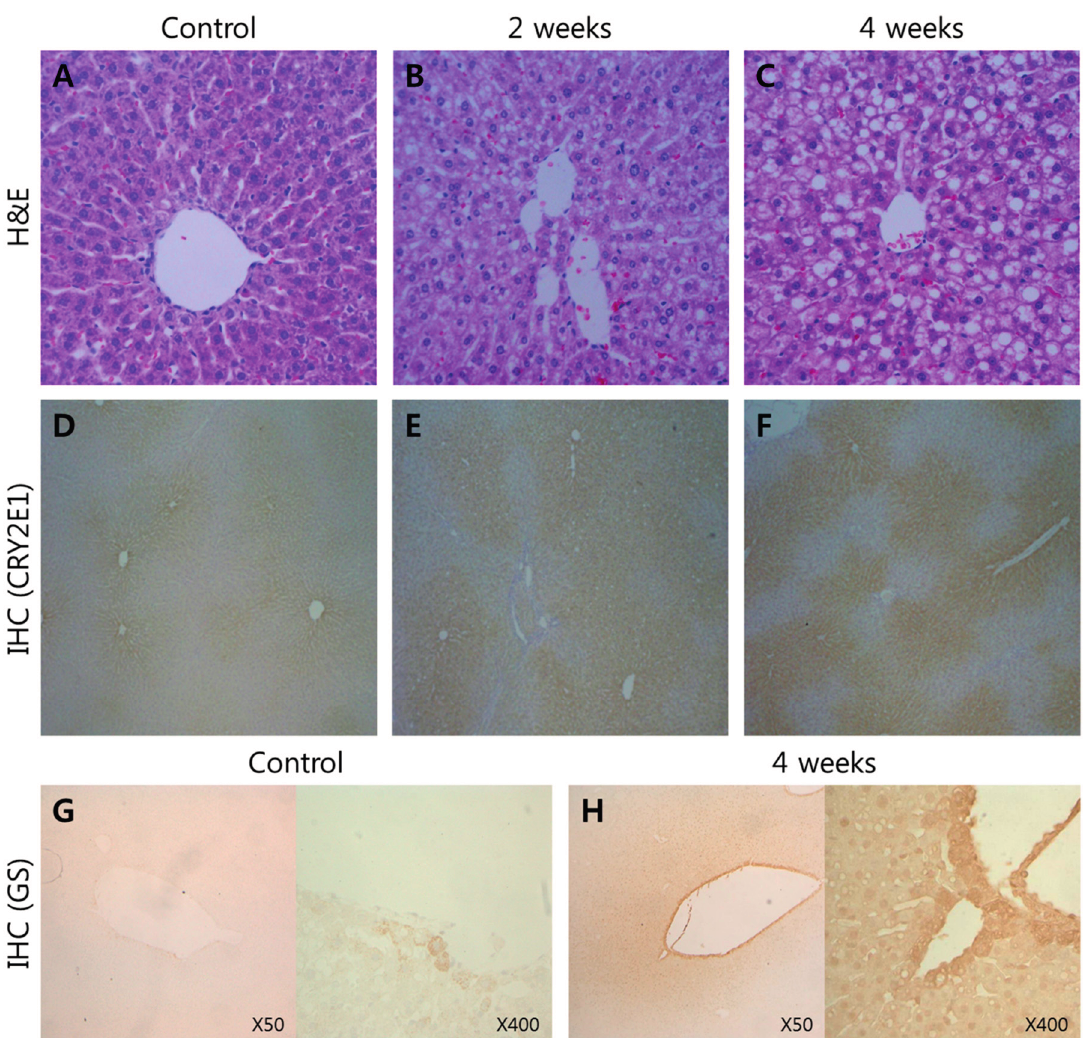
Figure 1. Histopathological and immunohistochemical changes in ethanol fed rat liver. ( A ) Normal control diet-fed rat liver; ( B ) Two weeks after an ethanol diet was fed to the rats. Hepatic fatty change and necrosis were visible in the cytoplasm of hepatocytes in the centrilobular areas of ethanol-fed rats; ( C ) Four weeks after the ethanol diet was fed to the rats. Hepatic fatty change and necrosis were more severe than that observed in B , and prominent fatty changes were observed in hepatocytes (H&E staining, ×132); ( D ) Normal control diet fed rat liver. CYP 2E1 immunoreactivity was relatively weak; ( E ) Two weeks after the rats were fed an ethanol. CYP 2E1 expression increased in pericentral hepatocytes at two weeks compared to D ; ( F ) Four weeks after the rats were fed an ethanol. Expression of CYP 2E1 was stronger than that observed in E (×66); ( G ) Normal control diet fed rat liver. GS expression was week; and ( H ) Four weeks after the rats were fed an ethanol. GS strongly expressed in perivenous hepatocytes. (×50 and